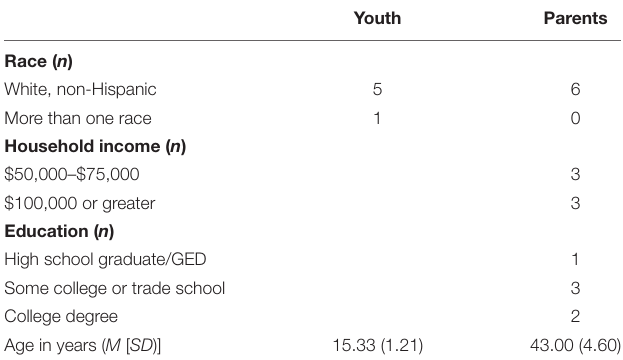
TABLE 1 | Sample demographics.